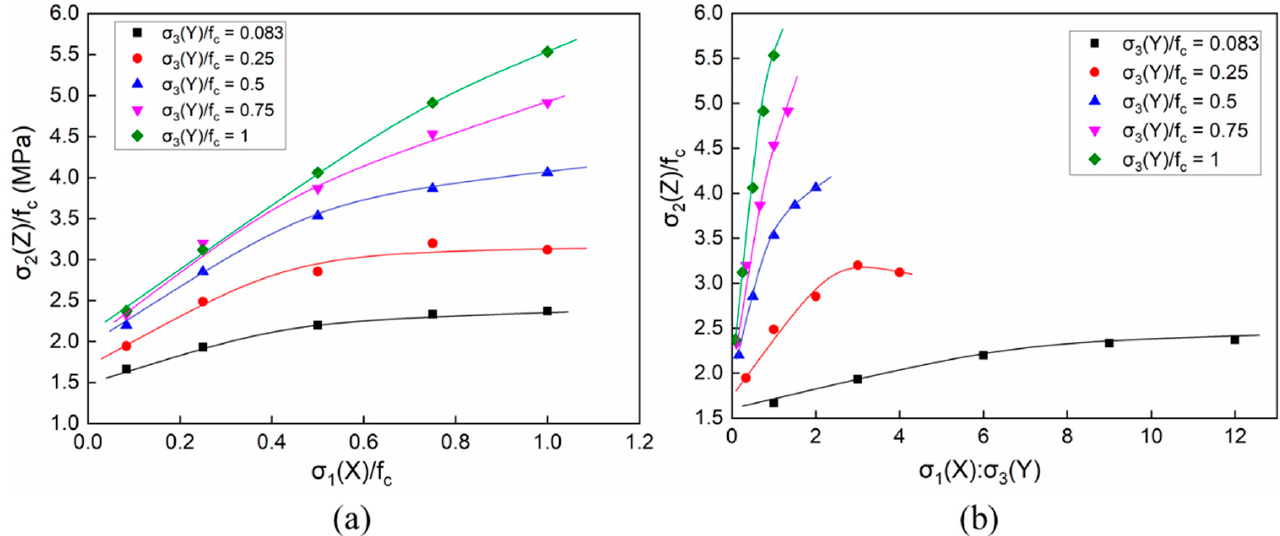
Figure 12. The compressive strength of concrete under triaxial compression: ( a ) σ 1 /f c of the horizontal axis and ( b ) σ 1 / σ 3 of the horizontal axis.